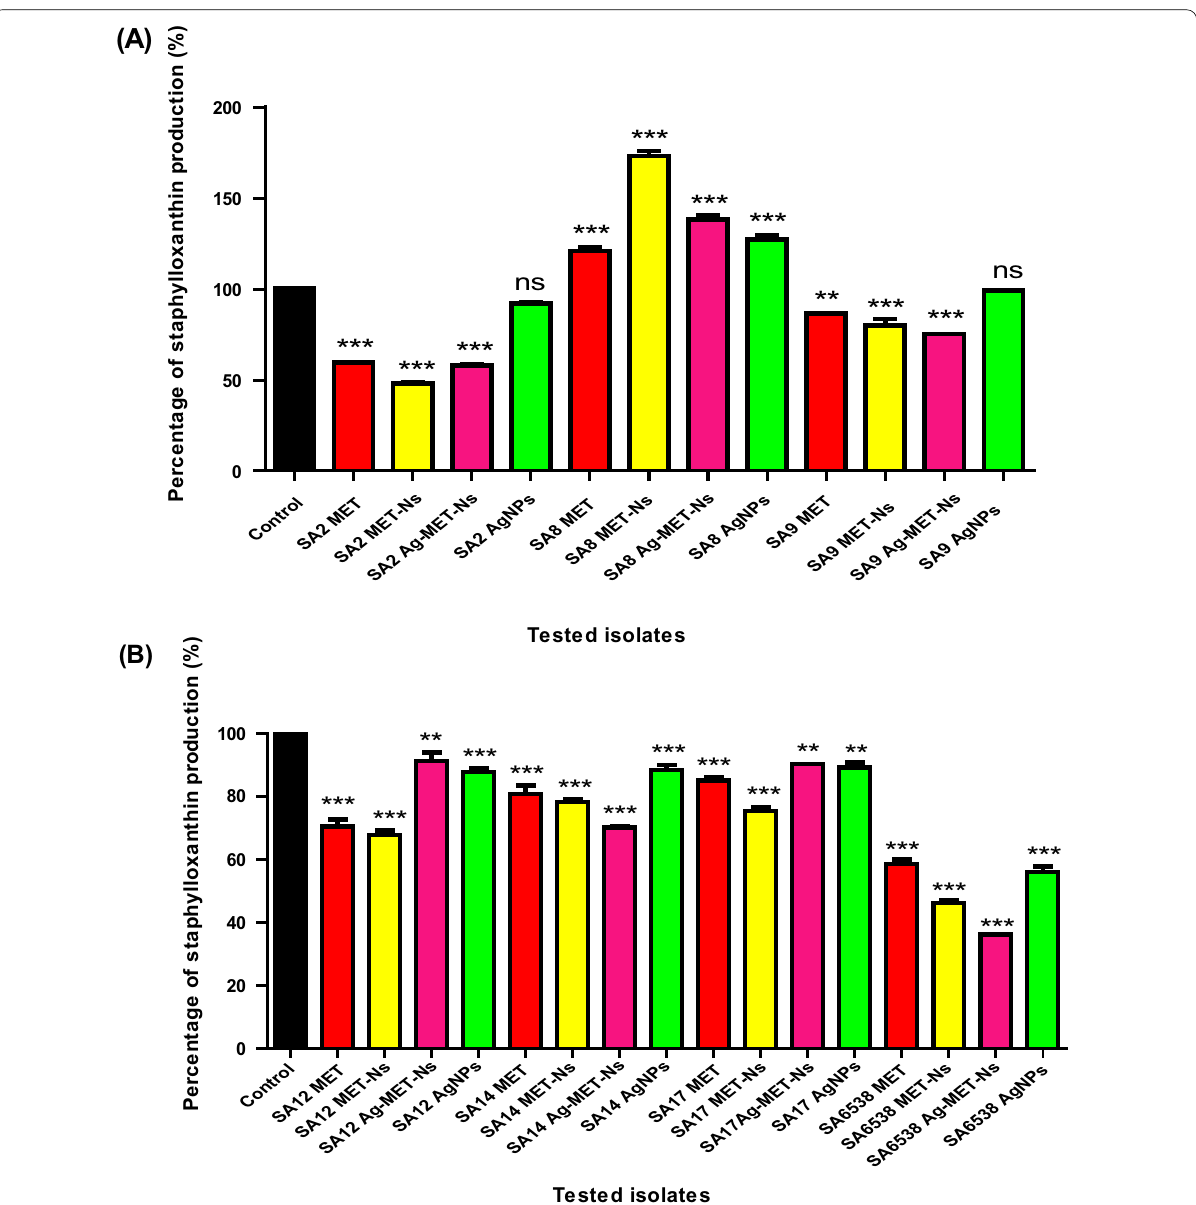
Fig. 3 Inhibition of Staphyloxanthin pigment production by 1/10 MICs of the tested agents. The pigment was extracted with methanol from treated and untreated bacterial cells and the yellow pigment was measured at OD 450 nm. The data shown represent the means *; significant P < 0.05, ns;